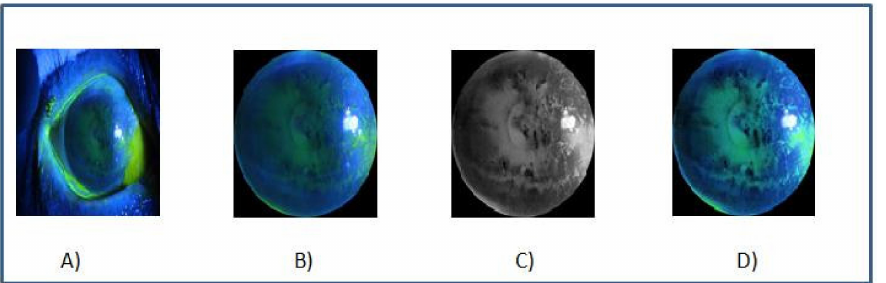
Figure 5. ( A ) Original image, ( B ) cornea area, ( C ) enhanced gray image, and ( D ) final enhanced